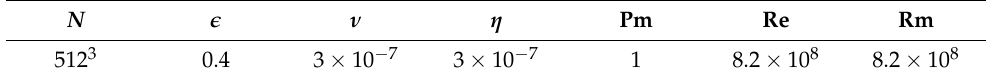
Table 1. Simulation parameters: Grid resolution ( N ), energy injection rate ( (cid:101) ), kinematic hypervis- cosity ( ν ), magnetic hyperdiffusivity ( η ), Magnetic Prandtl number (Pm), kinetic Reynolds number Re = u rms L 3 / ν and magnetic Reynolds number Rm = u rms L 3 / η , where L = 2 π is the box size. N (cid:101) ν η Pm Re Rm 512 3 0.4 3 10 − 7 3 10 − 7 1 8.2 10 8 8.2 10 8 × × × ×